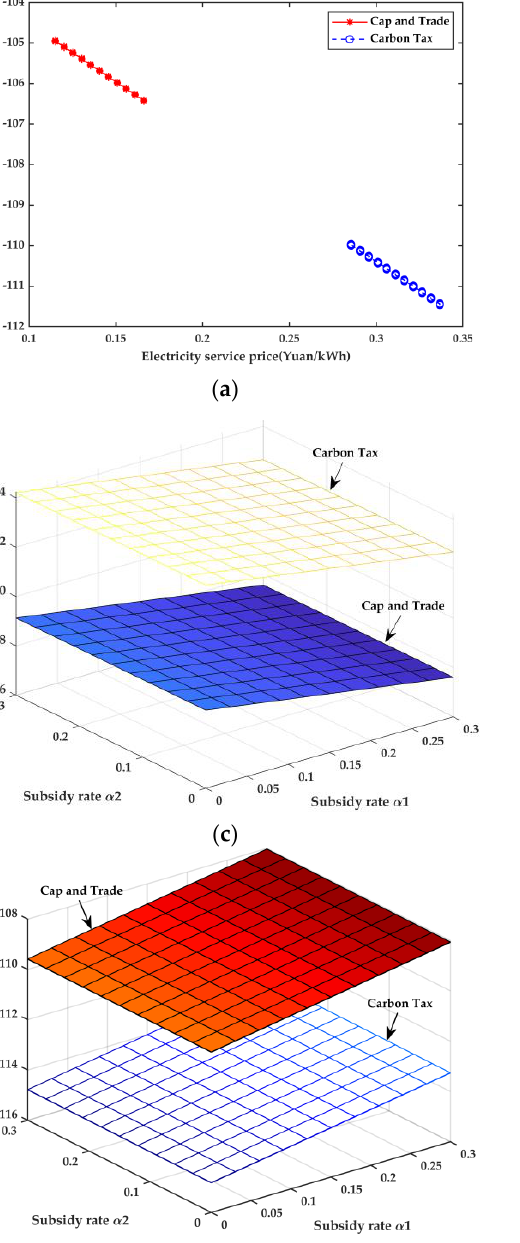
Figure 6. The relationship between subsidies and the benefits to all parties. ( a ) The relationship between electricity service price and social welfare; ( b ) The relationship between subsidy and social welfare; ( c ) The relationship between subsidy and government benefit; ( d ) The relationship between subsidy and port benefit; ( e ) The relationship between subsidy and ship